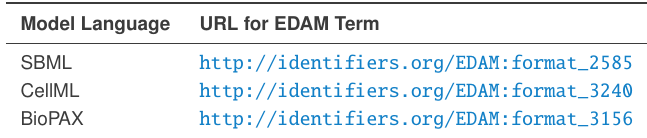
Table 15: Terms from the EDAM ontology to specify the language property of a Model .